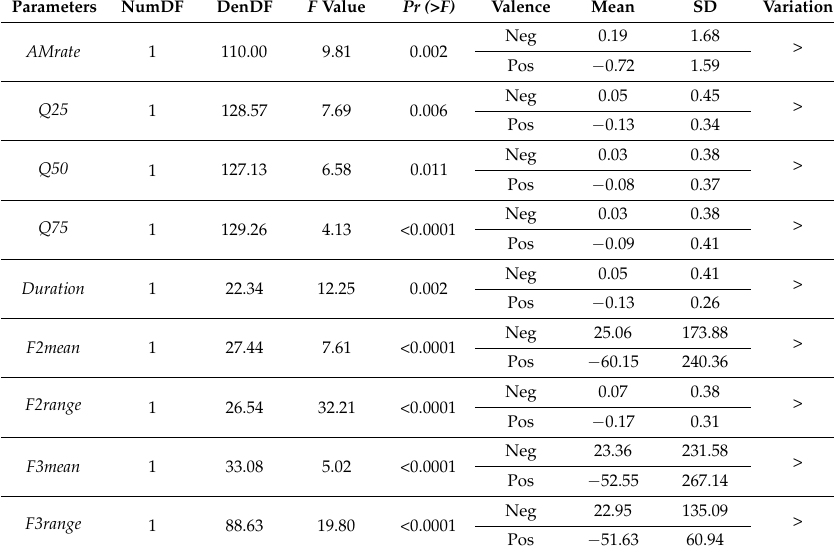
Table 5. Effect of valence attributed to the recording situations on the measured acoustic parameters (only significant values are shown). Residuals of the models controlled for the following factors: body movement, sex, age, size of the group, and type of call (see Supplementary Table S1 for raw values). The direction of the effect is displayed (< denotes an increase from negative to positive valence; > denotes a